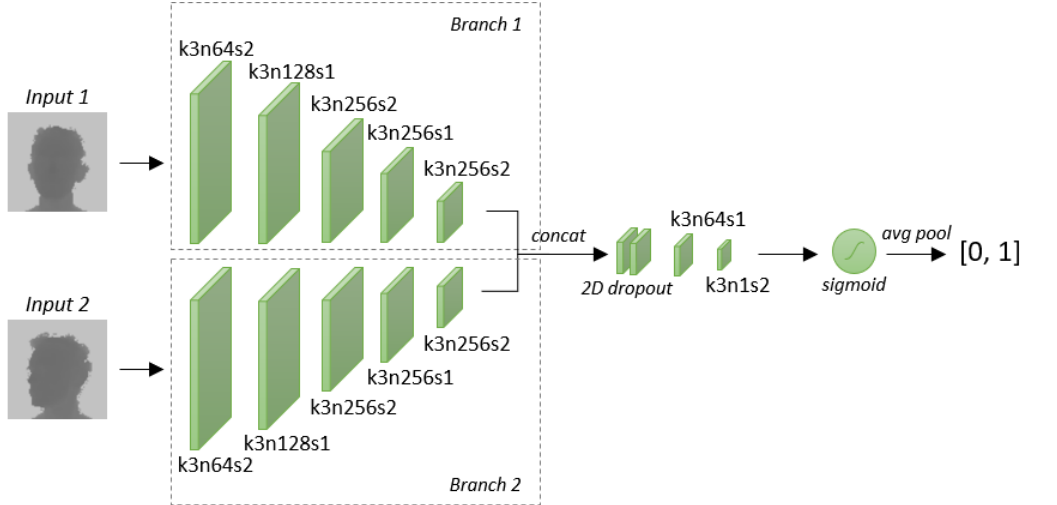
Figure 1. Overview of the proposed fully-convolutional Siamese architecture. The network takes a couple of facial depth maps as input and provides a continuous value in the range [ 0,1 ] as output, which is the probability that the input images belong to the same identity. Kernel size ( k ), number of filters ( n ), and stride size ( s ) are reported as the main parameters of each convolutional layer. With concat we refer to the concatenation on the feature